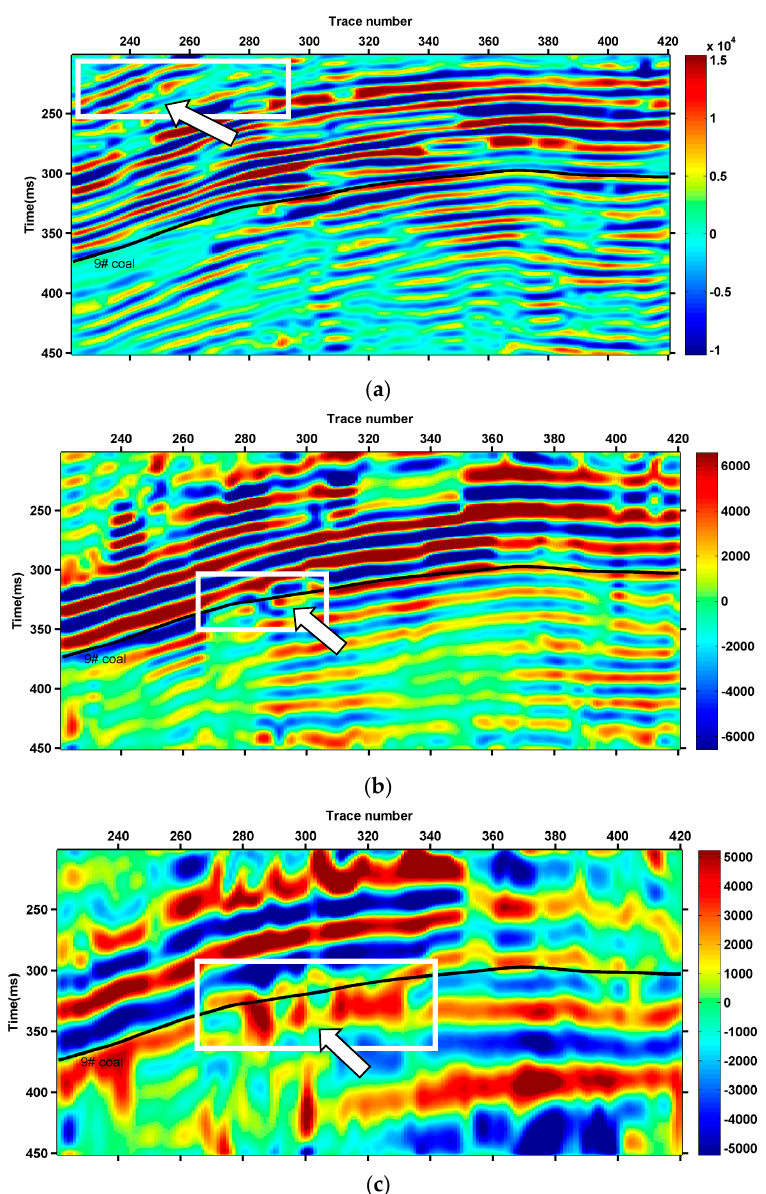
Figure 10. Results of EMD: ( a ) IMF1 of original seismic data; ( b ) IMF2 of original seismic data; ( c ) IMF3 of original seismic data.